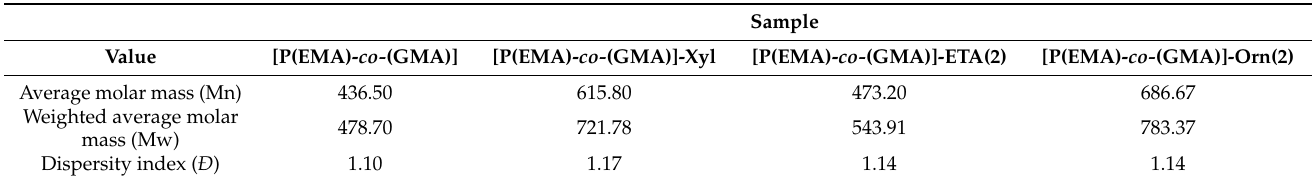
Table 1. Average molar mass determinations for the methacrylate oligomer derivatives obtained by size-exclusion chromatography.